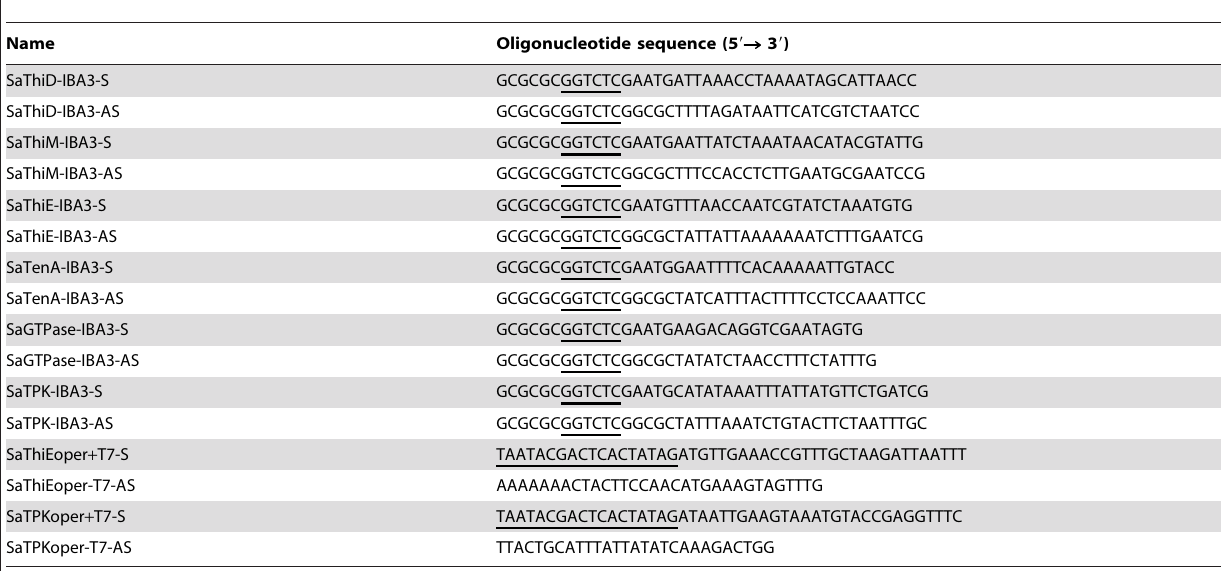
Table 2. Oligonucleotides used for RT-PCR and for amplification of the potential 5 9 UTRs as well as for cloning of the ORFs Sa ThiD, Sa ThiM, Sa ThiE, Sa TenA, Sa GTPase and Sa TPK.